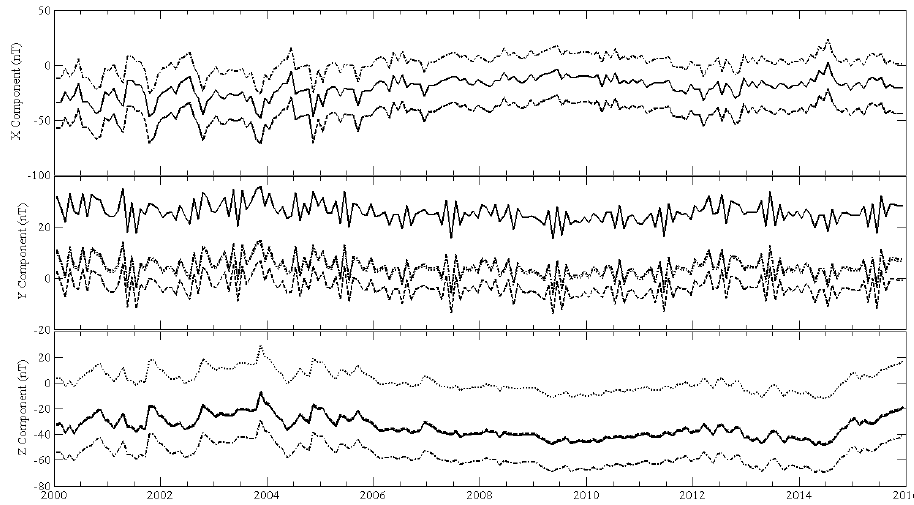
Figure 5. X, Y, Z - component differences between monthly mean values at NGK observatory and respective values predicted by POMME-9 model with maximum degrees L: a) 133 (dash-dotted line), b) 95 (solid line), c) 65 (dotted line), d) 45 (dashed line).